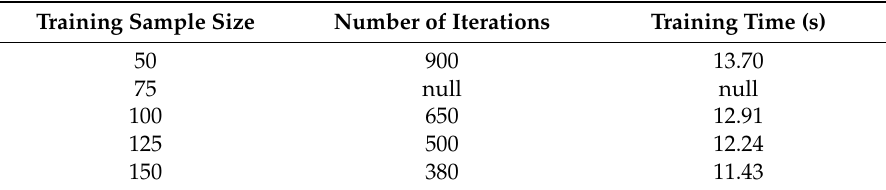
Table 9. Convergence training time test.